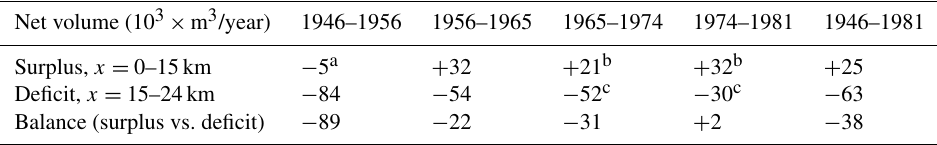
Table 1. Volumes of change of sand ( × 10 3 m 3 per year), distributed by decades and by region (oval delta in the north, x = 15–24km, and beaches west of it, x = 0–15km).